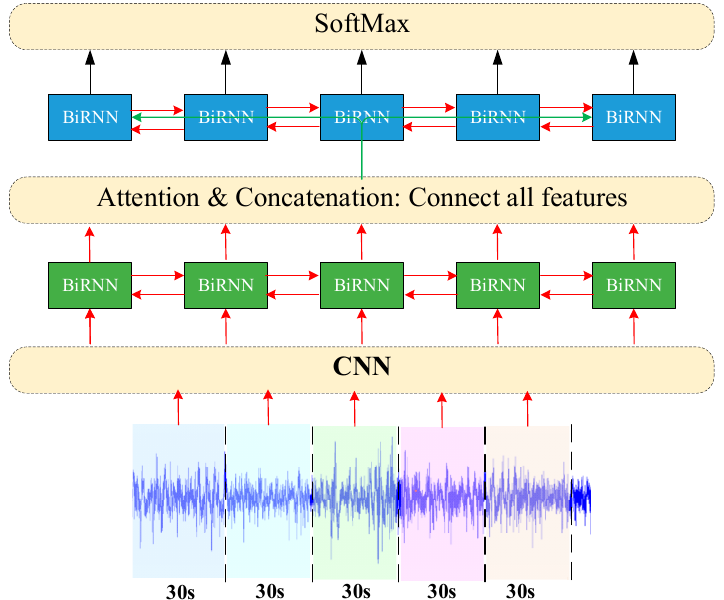
Figure 2. Flowchart of the proposed model.